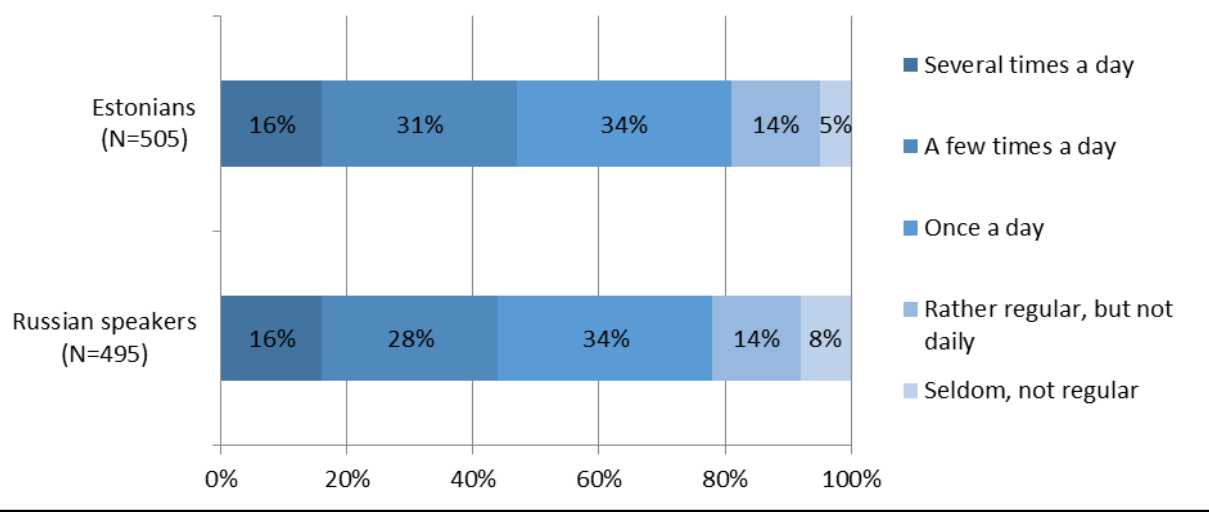
Figure 1. Frequency of following the news. Source: Saar Poll